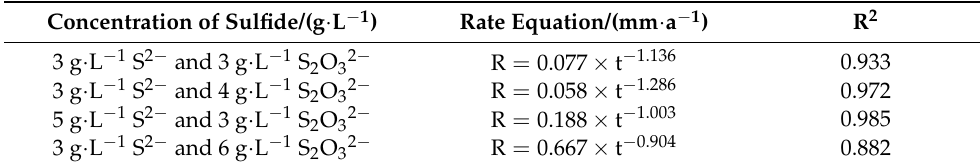
Table 2. Fitting results of corrosion kinetics. Concentration of Sulfide/(g · L − 1 )